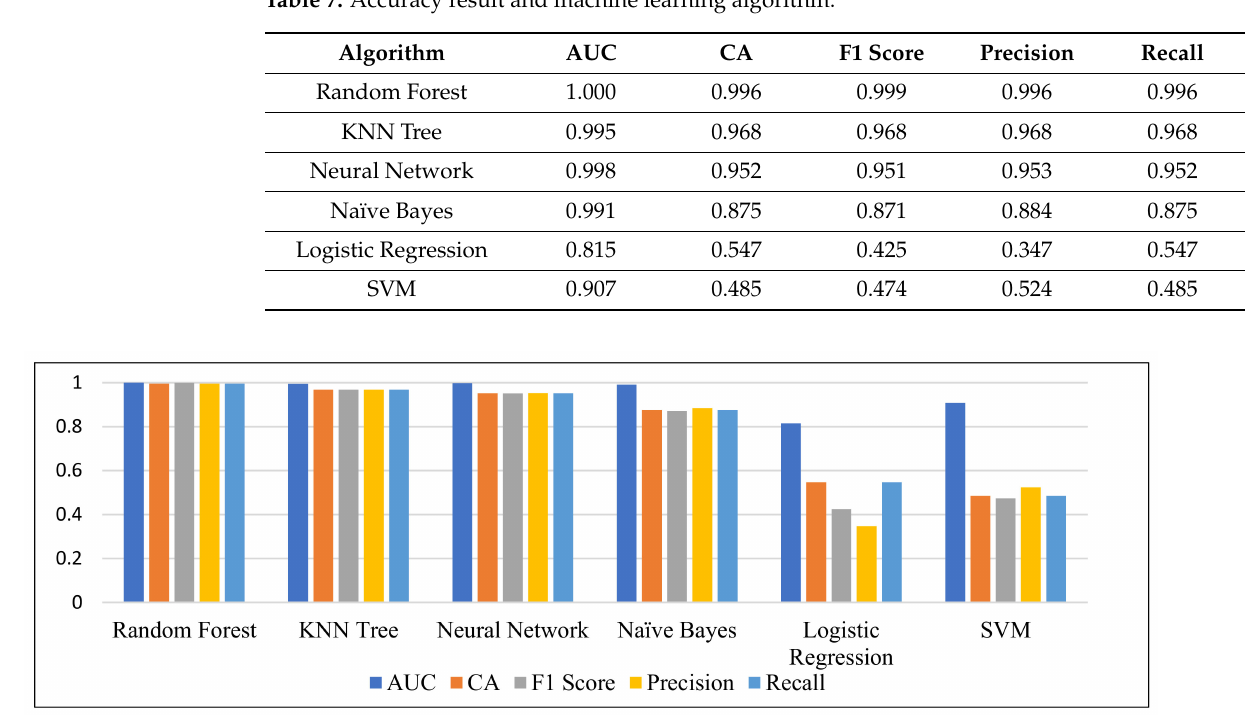
Figure 7. Graph of device classification results with